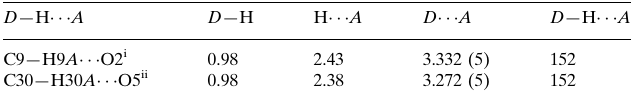
Hydrogen-bond geometry (A˚ , (cid:3)